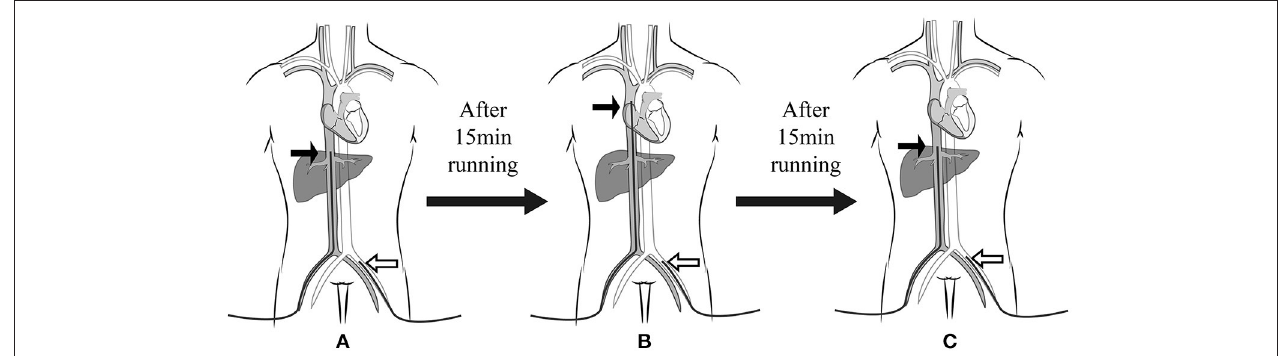
FIGURE 1 | Experimental procedure. The femoral drainage cannula was shifted three times at an interval of 15min. The femoral drainage cannula position after each move was (A) at the IVC level, (B) SVC level, and (C) IVC level again. The black arrow indicates the drainage cannula, and the white arrow indicates the return cannula. IVC, inferior vena cava; SVC, superior vena